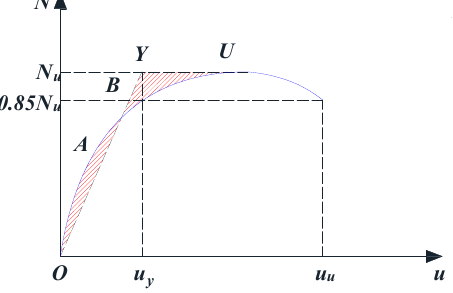
Figure 15. Schematic diagram of energy equivalent method.